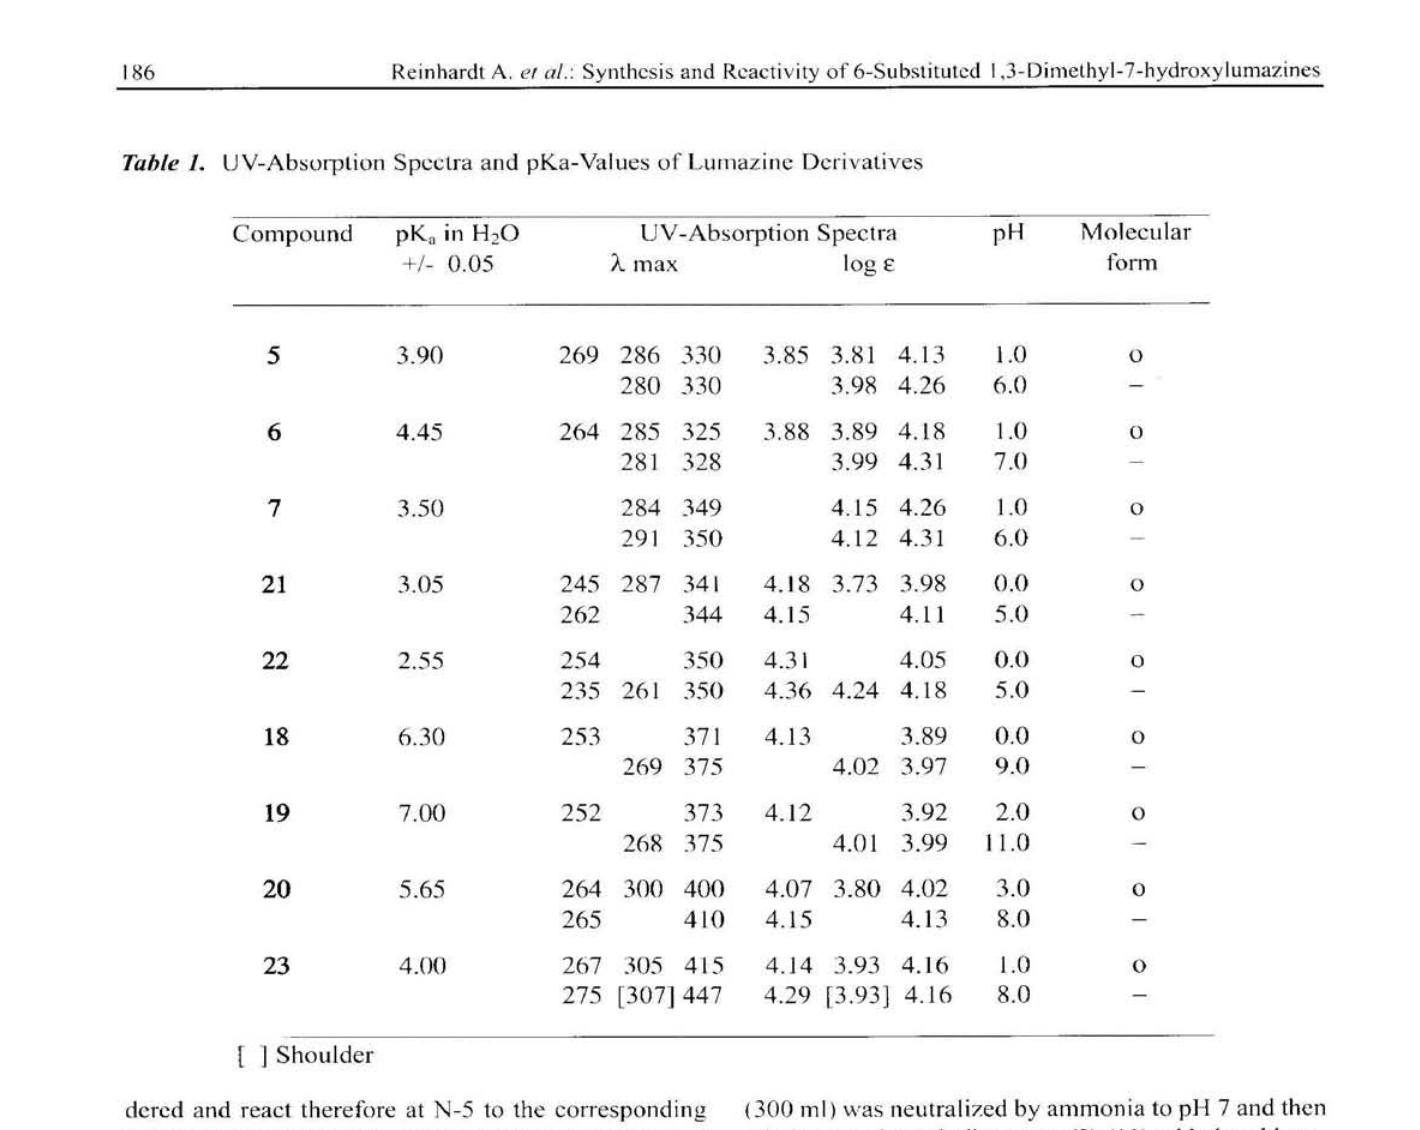
Table 1. UV-Absorption Spcctra and pKa-Values of Lumazine Derivatives Compound pK a in H 2